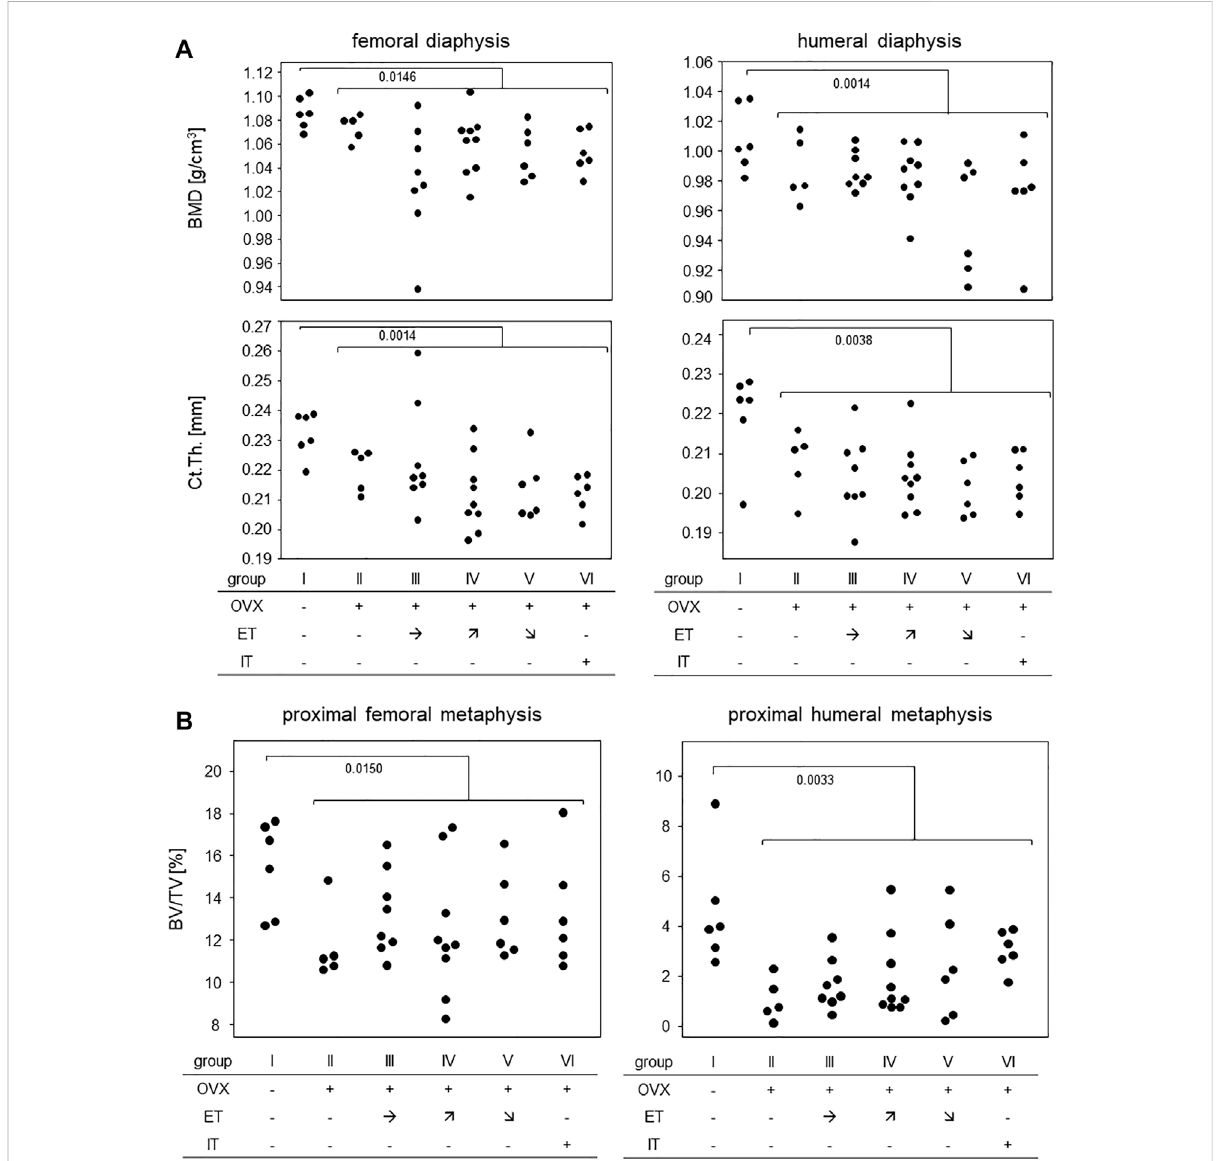
FIGURE 6 TreadmilltrainingdidnotpreventOVX-inducedboneloss. (A) showsbonemineraldensityandcorticalthicknessofthefemoral(leftpanels)and humeral (right panels) diaphysis. (B) shows BV/TV in the proximal metaphyses of femora (left panel) and humerus (right panel). Statistics were calculated by Mann-Whitney U-test and statistically signi fi cant differences are indicated by p